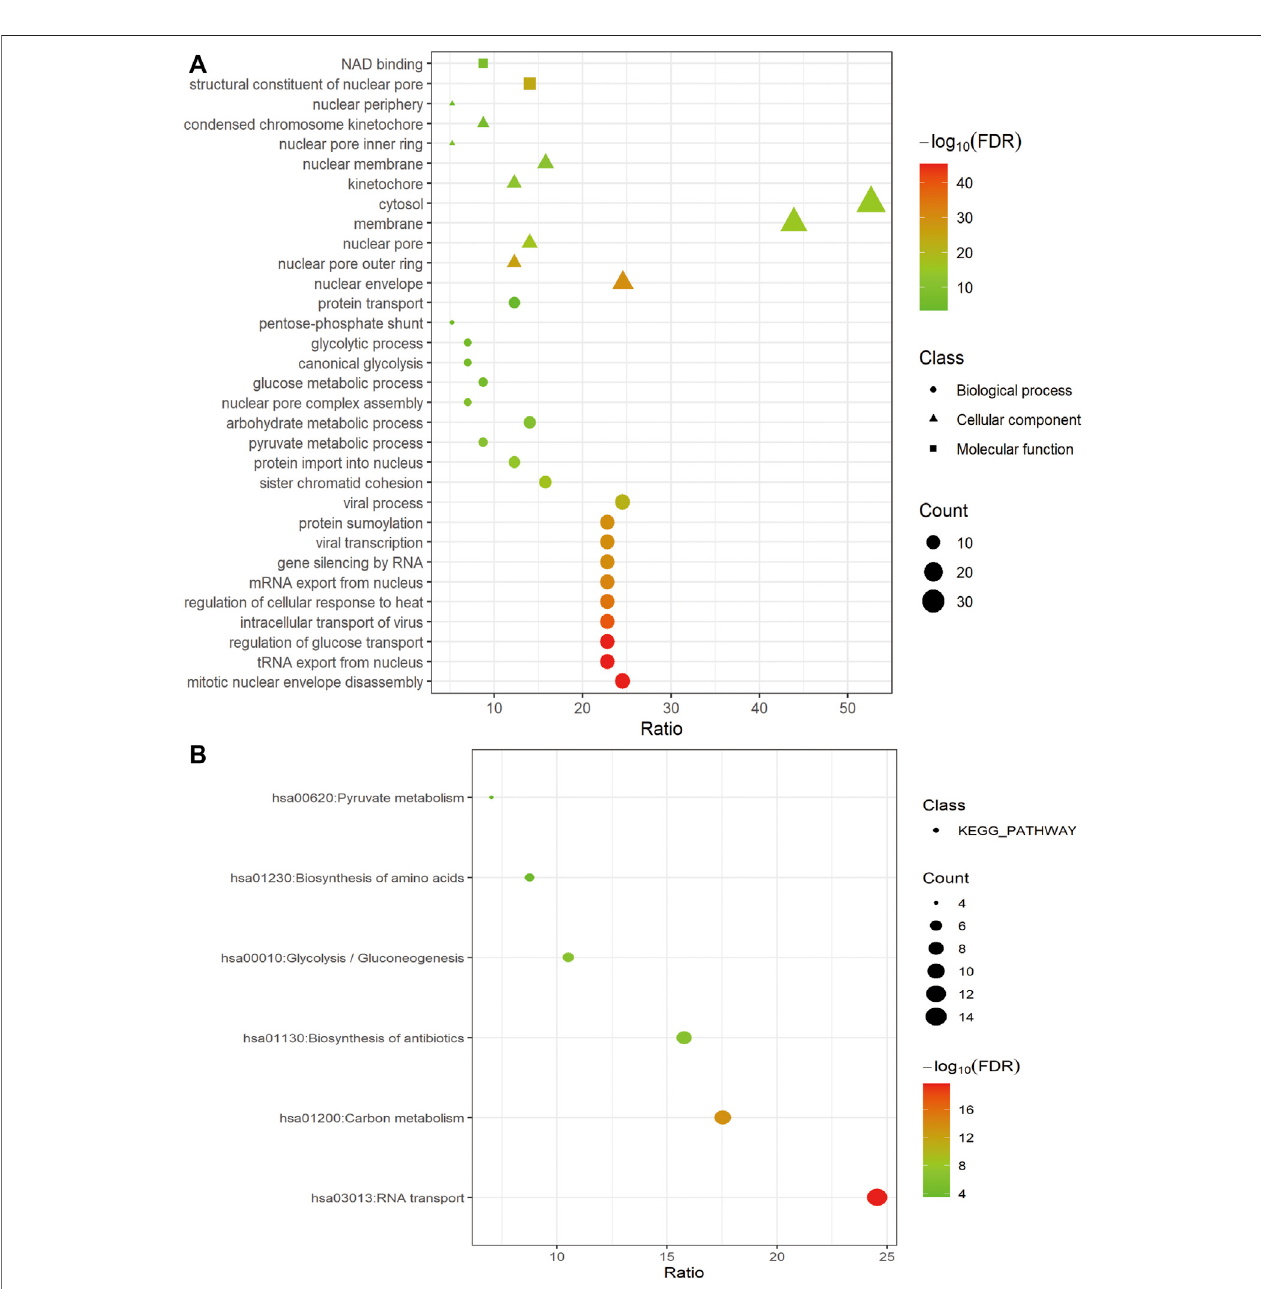
FIGURE 2 | Functional enrichment of prognosis-related GRGs. Bubble charts showing signi fi cantly enriched Gene Ontology terms of the biological process (indicated as dots), cellular component (indicated as triangles), and molecular function (indicated as squares) (A) and KEGG pathways (B) .